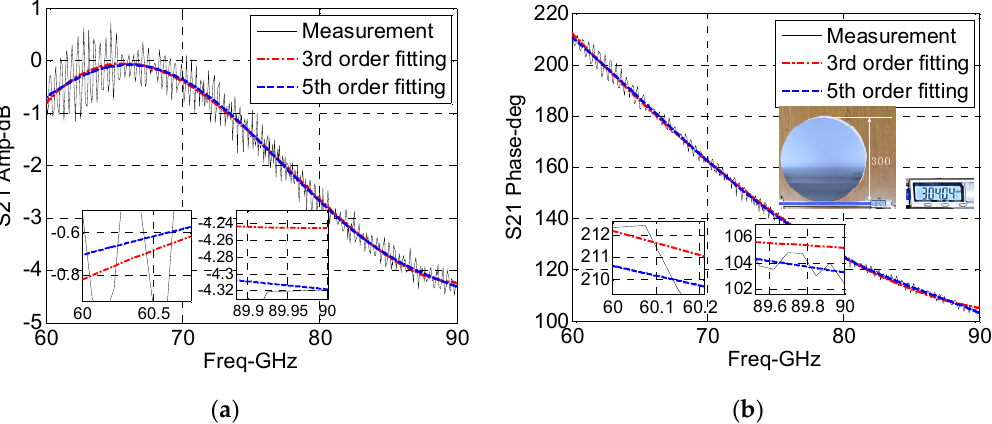
Figure 7. Raw data and fitting results of S21. ( a ) Amplitude; ( b ) phase.